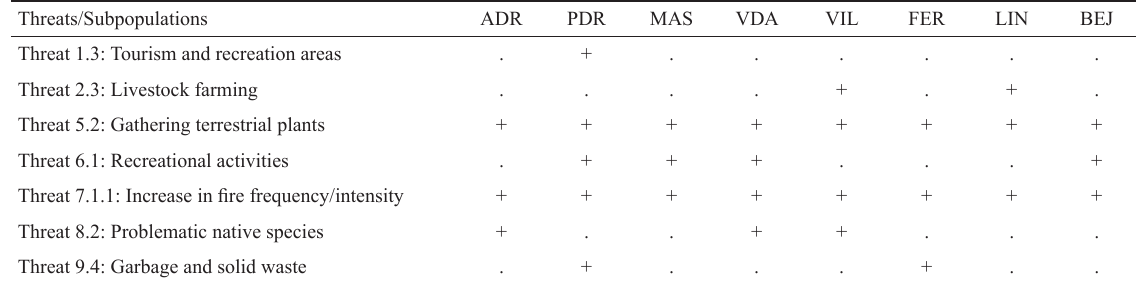
Table 2. Threats detected in each studied subpopulation of Delphinium fissum subsp. sordidum (see Table 1 for